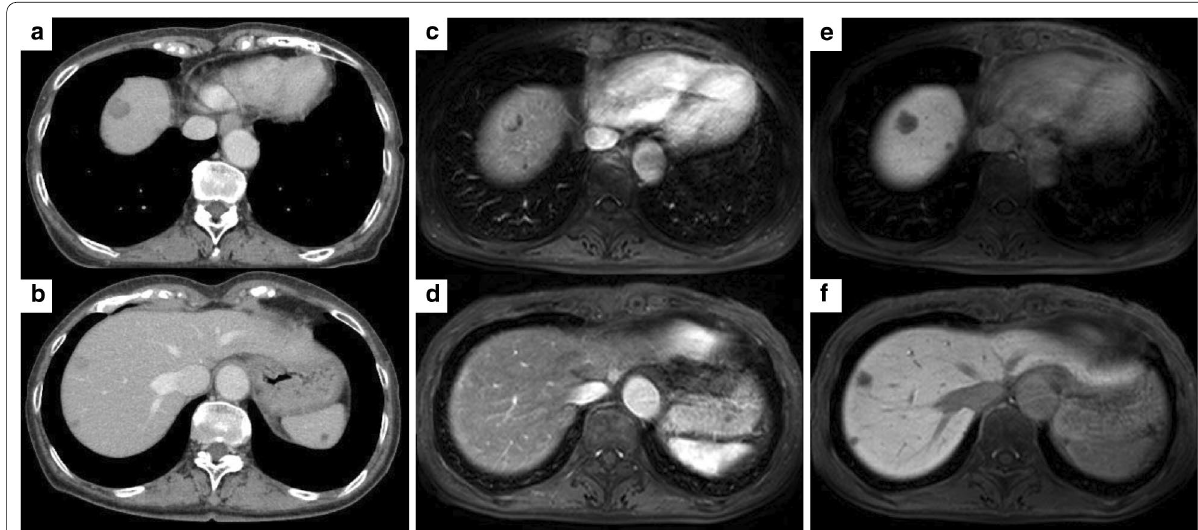
Fig. 1 a , b CT image. Four tumors are seen in liver segments S7 and S8. c – f EOB-MRI image. The tumor edges are hyperintense with dynamic imaging, and some enhancement is exhibited within the tumors